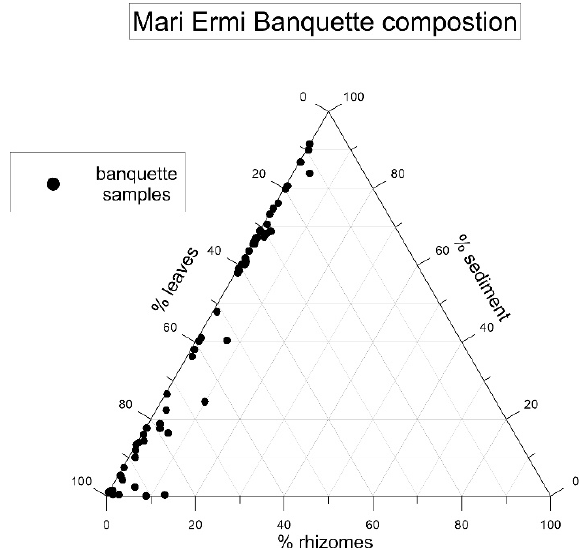
Figure 4. Ternary plot representing Posidonia banquette composition in % of leaves, rhizomes and sediment. and sediment.